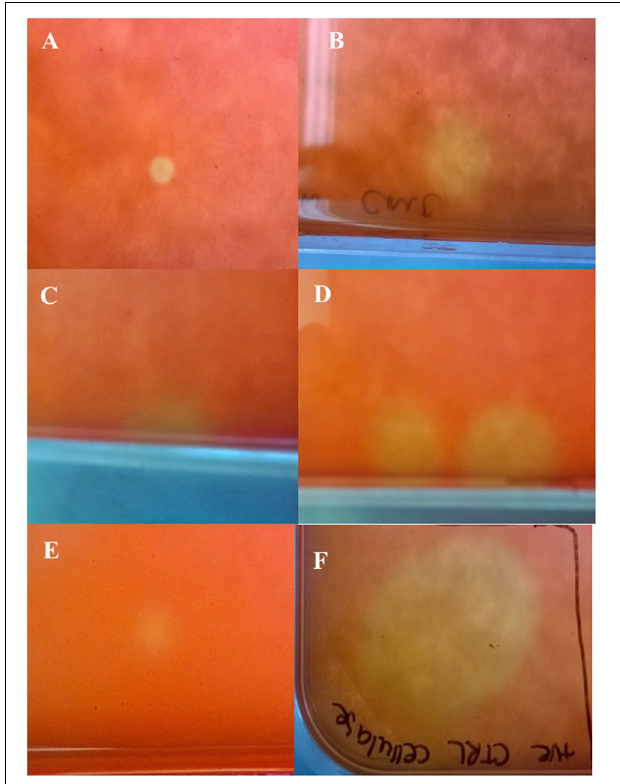
FIGURE 2 | Amplified cDNA library plated on Escherichia coli lawn with carboxymethyl cellulose overlay and post-staining with Congo red (Primary assay). (A–E) Cellulase positive plaques indicated by yellow coloring; (F) Positive control (cellulase from Aspergillus niger ) indicated by yellow